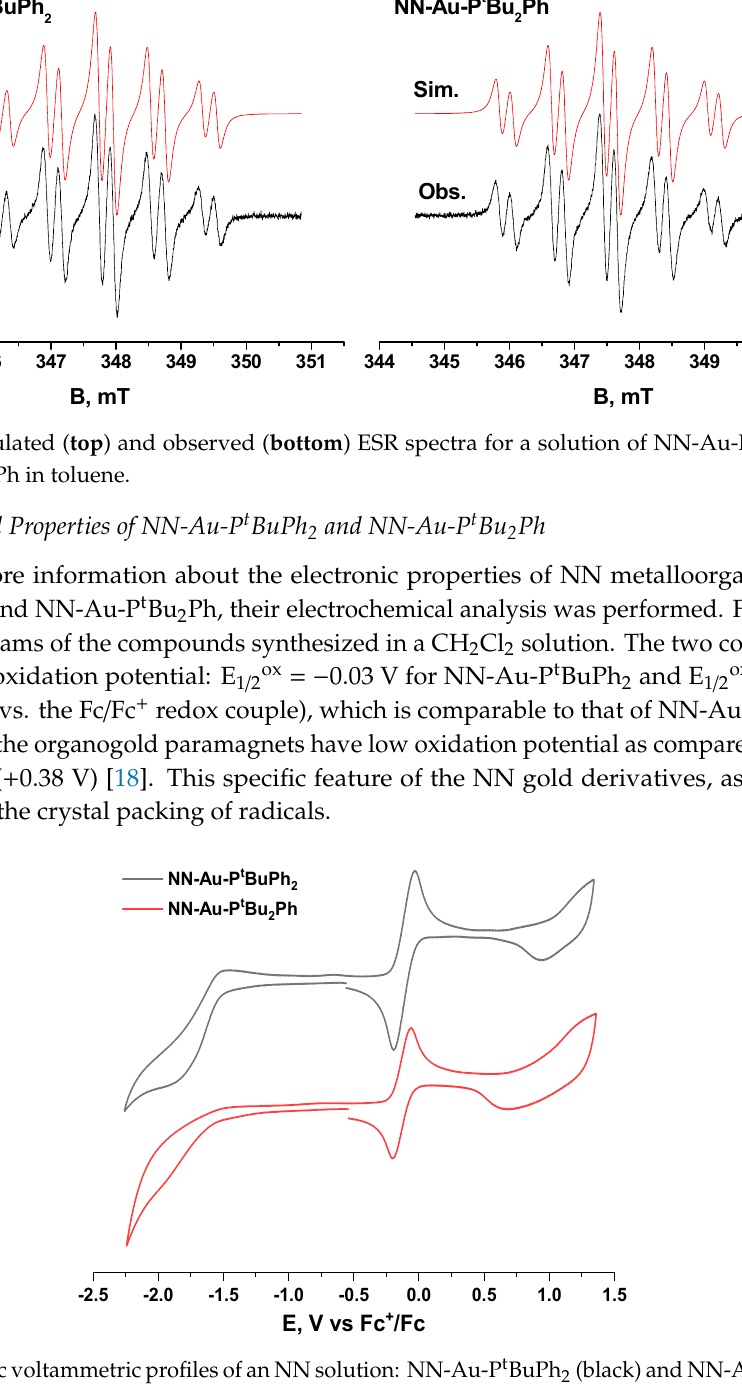
Figure 8. Cyclic voltammetric profiles of an NN solution: NN-Au-P t BuPh 2 (black) and NN-Au-P t Bu 2 Ph (red) (0.1 M Bu 4 NPF 6 as the supporting electrolyte in dichloromethane at a scan rate of 100 mV · s − 1 ; the potentials are presented relative to the Fc + /Fc redox couple).